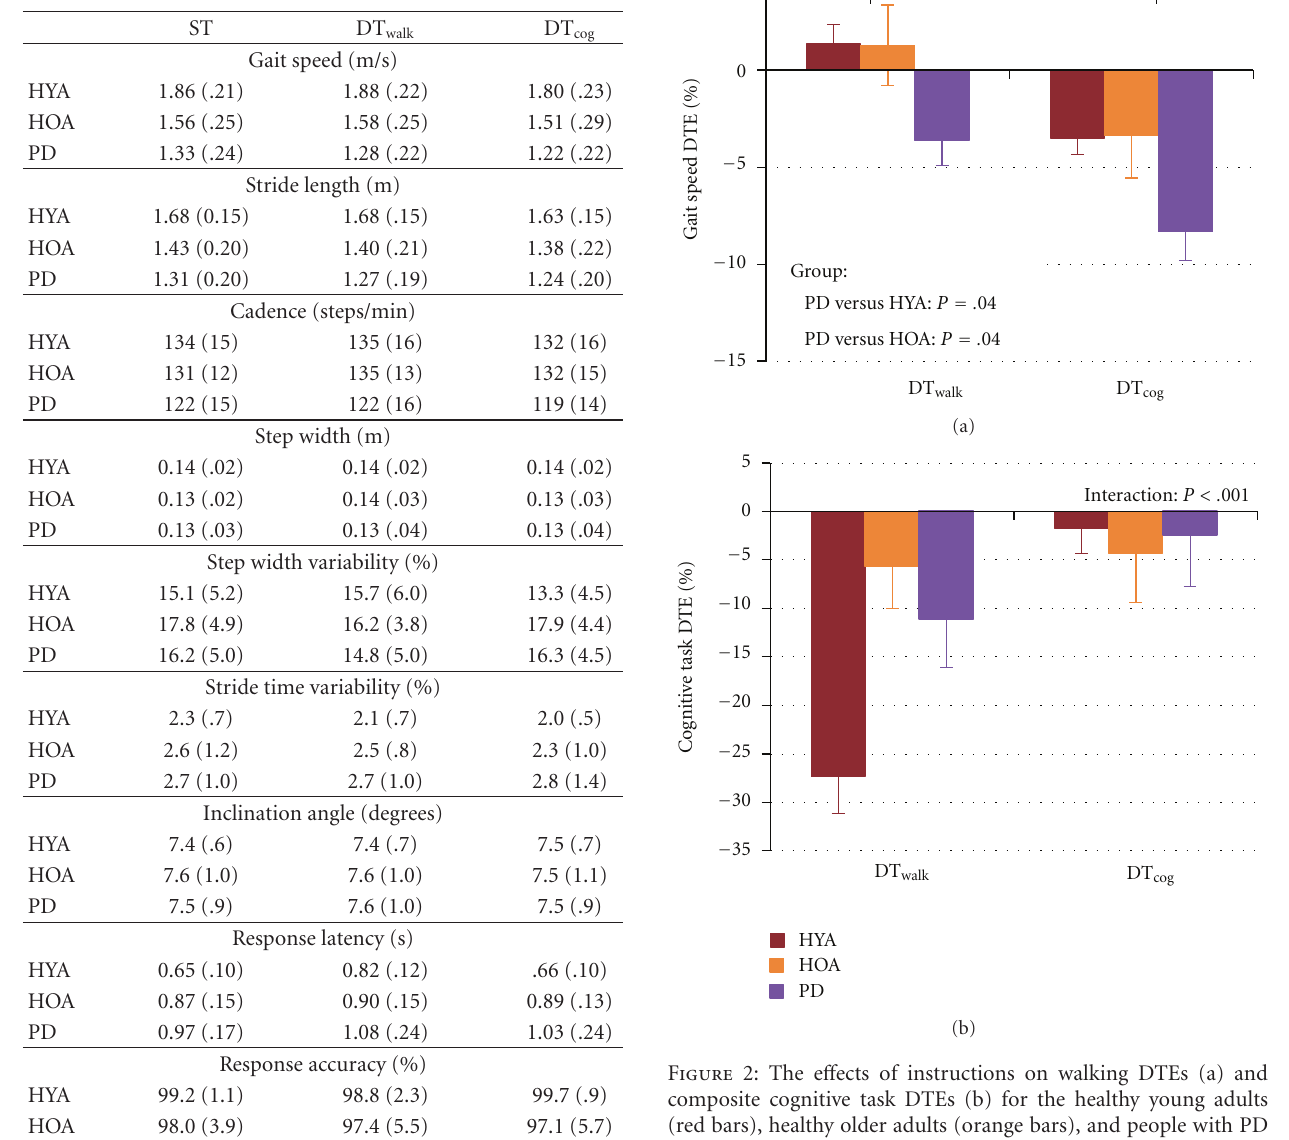
Table 2: Mean (SD) values for walking and the cognitive task values in all groups under single-task (ST) and both dual-task conditions.